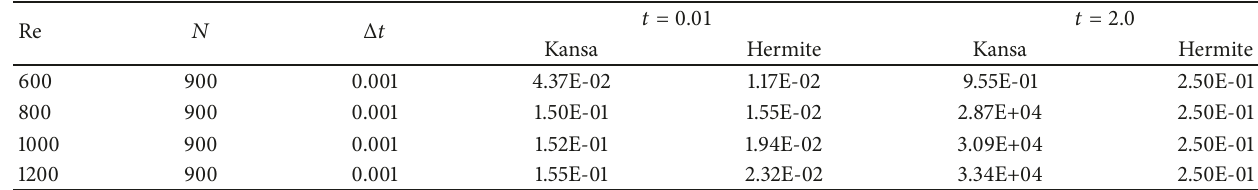
Table 7: Averaged 𝐿 ∞ - error obtained with 𝜀 = 0.001 for moderate to high Reynolds number.